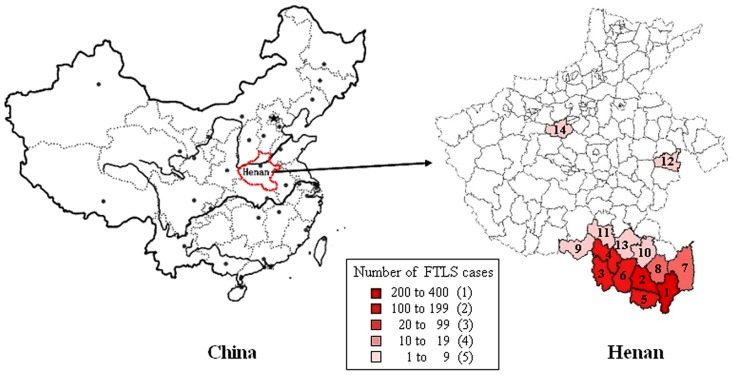
Map of Henan Province, showing laboratory-confirmed FTLS cases in 2011–2012.1 Shangcheng, 2 Guangshan, 3 Sihe), 4 Pingqiao, 5 Xinxian, 6 Luoshan, 7 Gushi, 8 Huangchuan, 9 Tongbai, 10 Xixian, 11 Queshan, 12 Luyi, 13 Zhengyang, 14 Dengfeng.